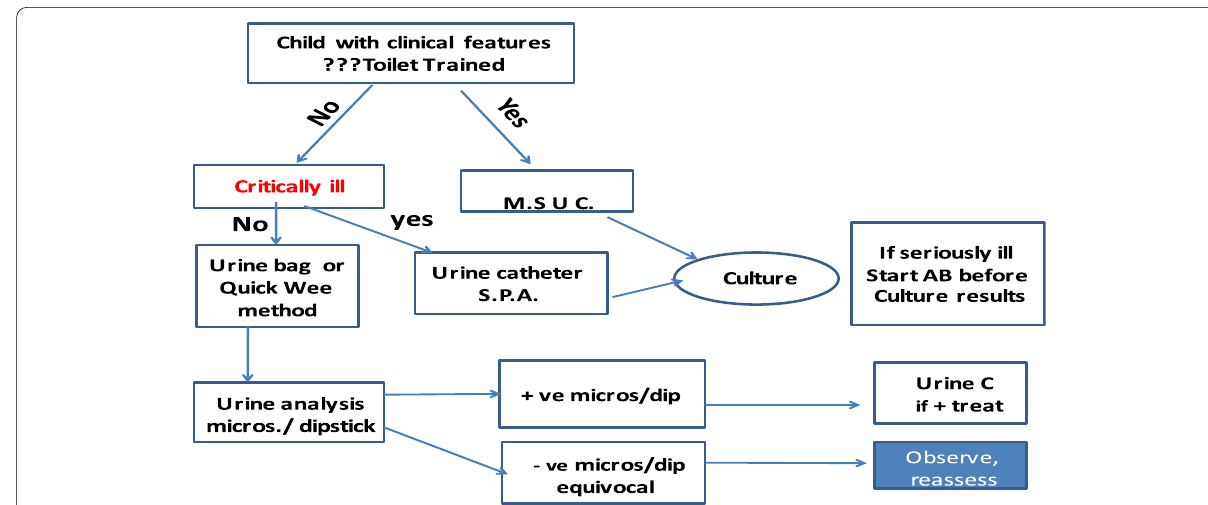
Fig. 2 National diagnostic workup plan. M.S.U.C midstream urine collection, S.P.A.S suprapubic aspirate sample, Cath catheterization, - ve negative, micros. microscopy, L. E leukocyte esterase, N nitrite, positive dip, negative microscopy, or vise versa, Urine C & S urine culture and sensitivity, AB